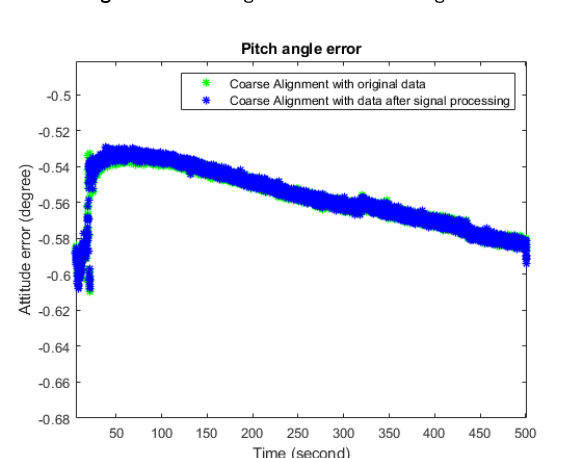
Figure 14 .Roll angle error in coarse alignment